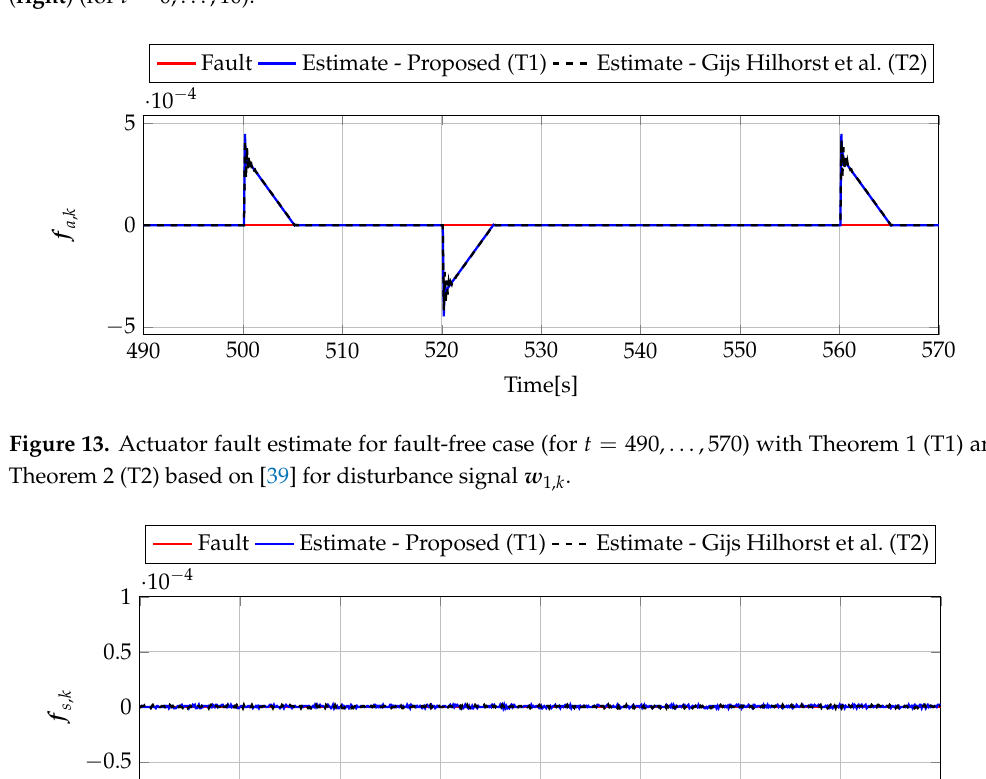
Figure 12. Disturbance signal w 1, k ( left ) (for t = 400, . . . ,700) and measurement noise signal w 2, k ( right ) (for t = 0, . . . ,10).